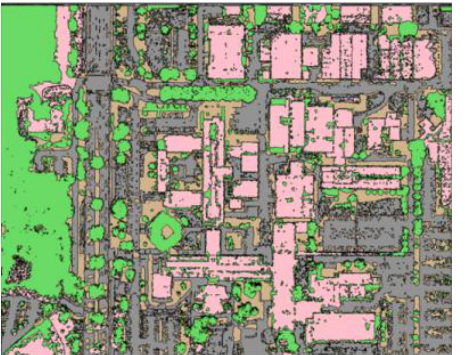
Figure 7: Results of Object-Based